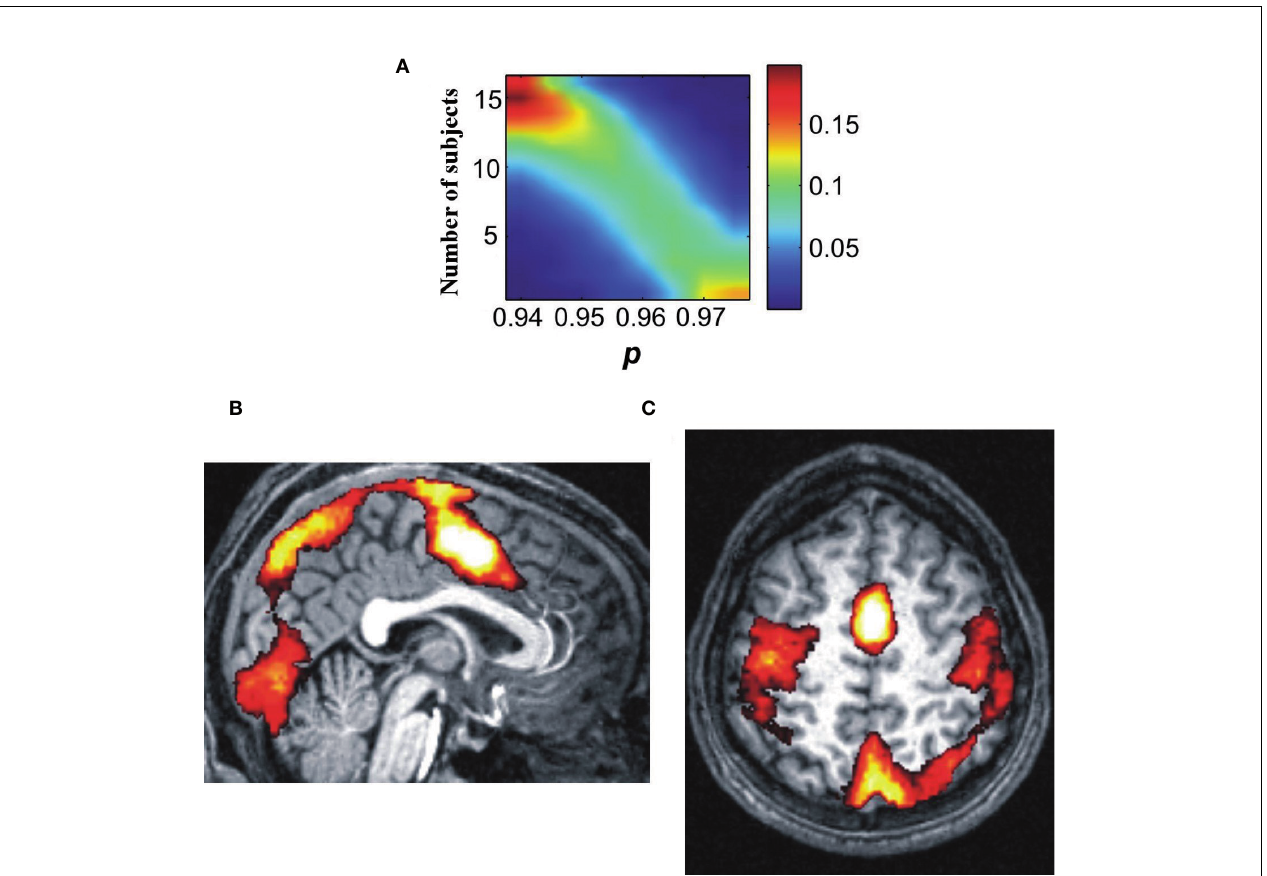
Spatial distribution of the first percolation clusters (in subject counts).The two brain slices show for the highest p-values the shared voxels.White bleached regions correspond to voxels which are included in the first percolation cluster for all subjects.The SMA, a region involved in planning motor action is the only shared region for all subjects.